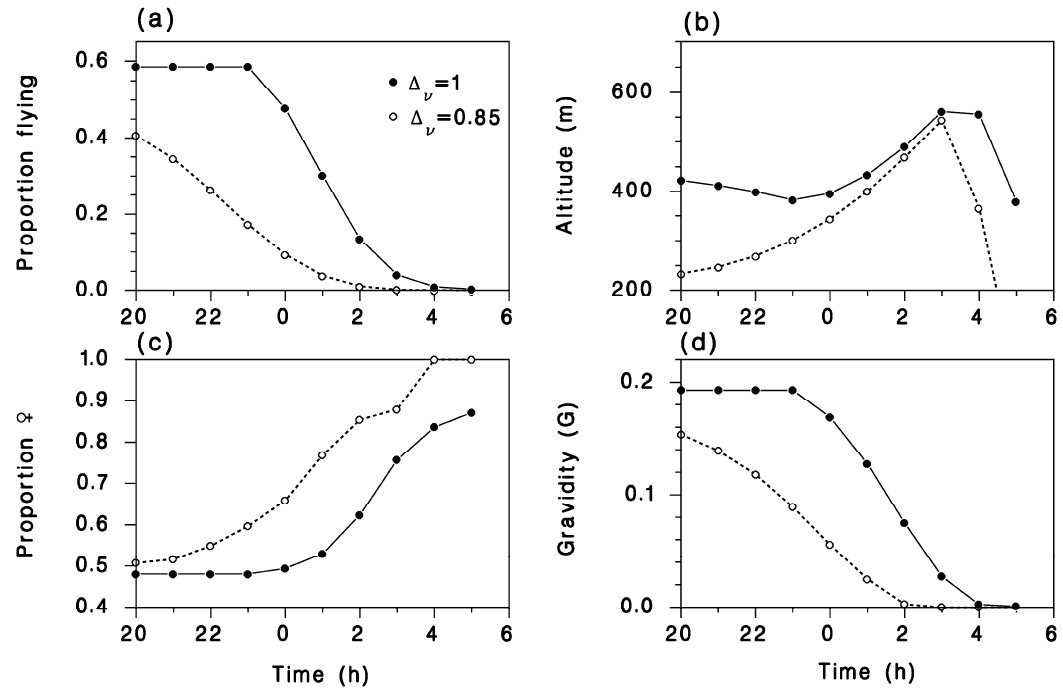
Figure 10. Summary of simulated migratory flights. ( a ) Proportion of moths in flight. ( b ) Mean flight altitude. ( c ) Proportion female among migrating moths. ( d ) Gravidity, the proportion of initial fecundity carried by migrating females. ● : Δ ν = 1.0; ○ : Δ ν = 0.85.